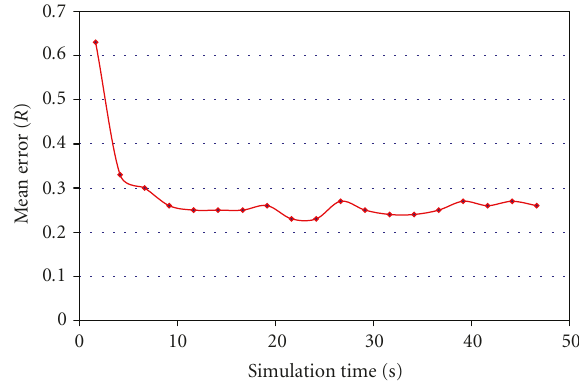
Figure 12: Performace by simulation time ( N = 25, G = 4, nodes speed = 10 m/s).